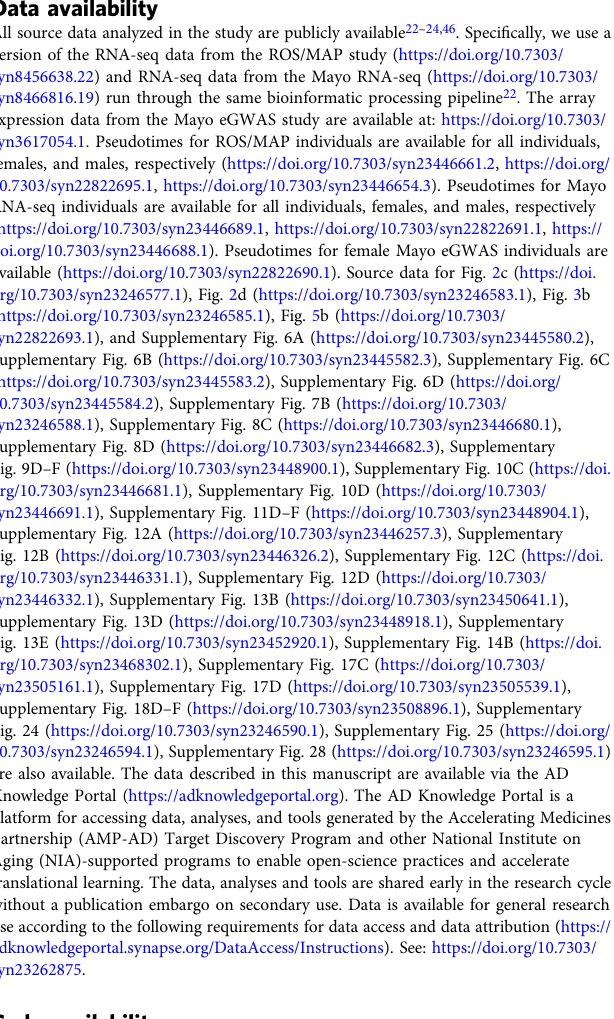
Fig. 12B (https://doi.org/10.7303/syn23446326.2), Supplementary Fig. 12C (https://doi. org/10.7303/syn23446331.1), Supplementary Fig. 12D (https://doi.org/10.7303/